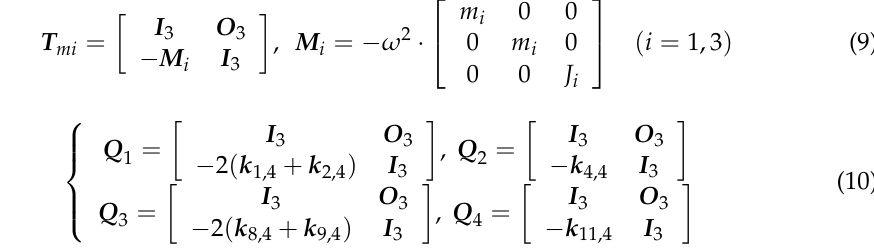
where I 3 and O 3 are the 3 × 3 unit and zero matrices. k i ,4 ( i = 1, 2, 4, 8, 9, 11) are the last